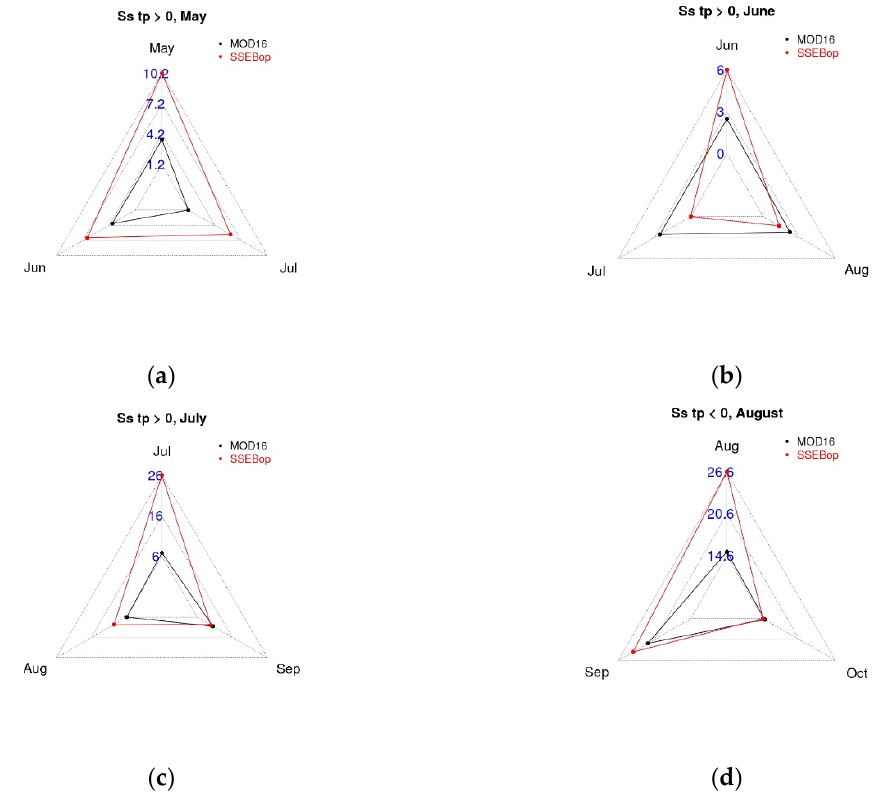
Figure 9. Area of overlapping between positive monthly tp trends in May, June, and July and positive monthly ET trends in the same and in the following two months ( a – c ), and between negative monthly tp trends in August and negative monthly ET trends in August, September, and October ( d ). Areas are expressed as percentage of the area with positive and negative ET trends (blue numbers).